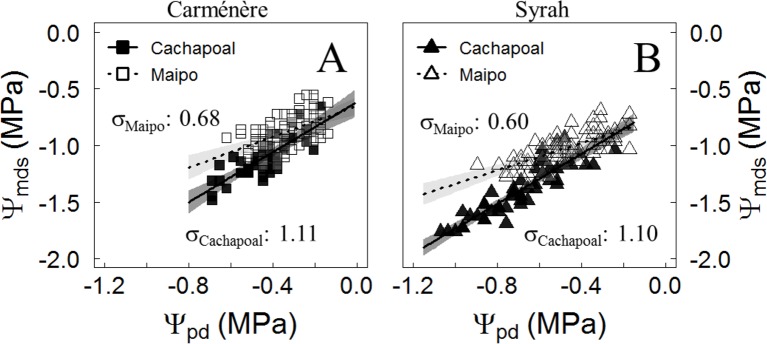
Midday water potential (Ψmds) responses to predawn water potential (Ψpd) in Carménère and Syrah grapevines. Trajectories from the relationship between Ψpd and Ψmds were used to estimate the degree of isohydricity in (A) Carménère and (B) Syrah plants during drought progression in the field in the Cachapoal (2017) and Maipo (2018) valleys in Chile. Squares correspond to Carménère and triangles are Syrah. Black and white symbols correspond to data from the Cachapoal Valley and Maipo Valley, respectively. The solid line shows the regression line, and the shaded area is the 95% confidence interval for the mean.